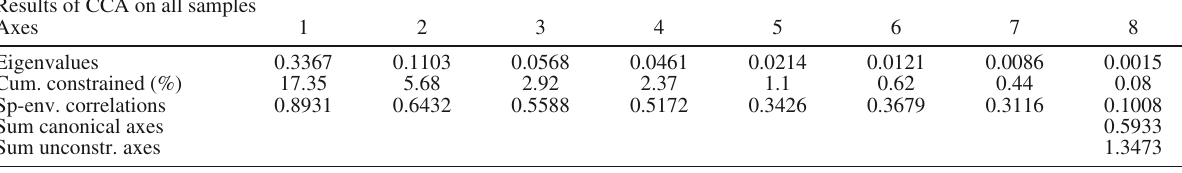
Table 4. – Results of canonical correspondence analysis (CCA) on all samples, inter-set correlations of environmental variables with CCA axes and variance inflation factors (VIFs) for the significant explanatory variables. Cum. constrained (%), cumulative constrained percentage; Sp-env. correlations, species-environmental variable correlations; Sum unconstr. axes, sum of all unconstrained axes; Sum canonical axes, sum of all canonical axes. Results of CCA on all samples